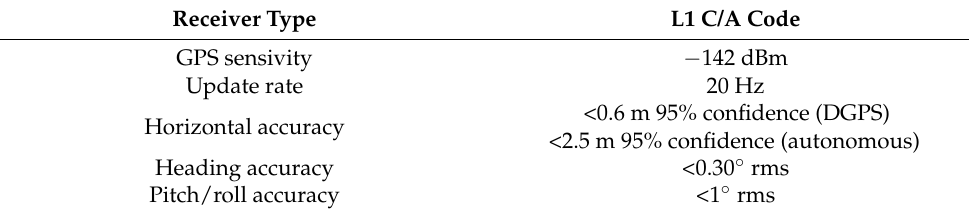
Table A5. Main features of Hemisphere Vector V103 Compass GPS